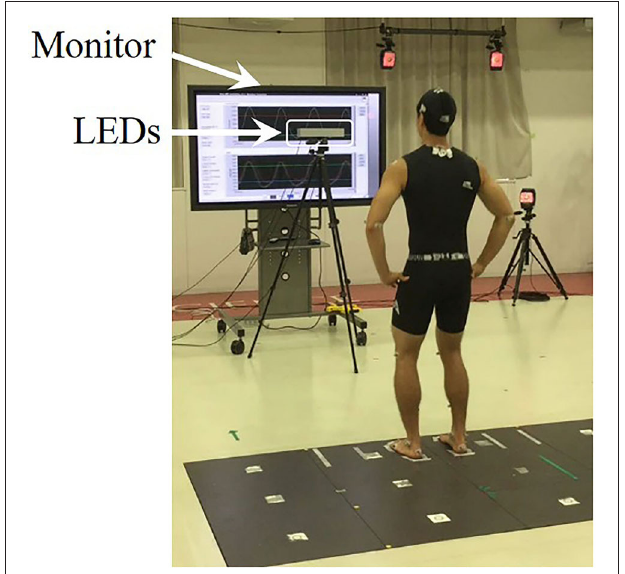
FIGURE 1 | Experimental setup. The subject stood barefoot with an inter-malleolar distance of 10% of their body height (BH). Three sets of LEDs (left, center, right) at their eye level were used to provide a visual cue. They were asked to step laterally as rapidly as possible in response to the visual cue, at 10–20% BH from the lateral malleolus of the stepping foot. A monitor placed behind the LEDs provided real-time visual feedback of the vertical GRF in the P condition.